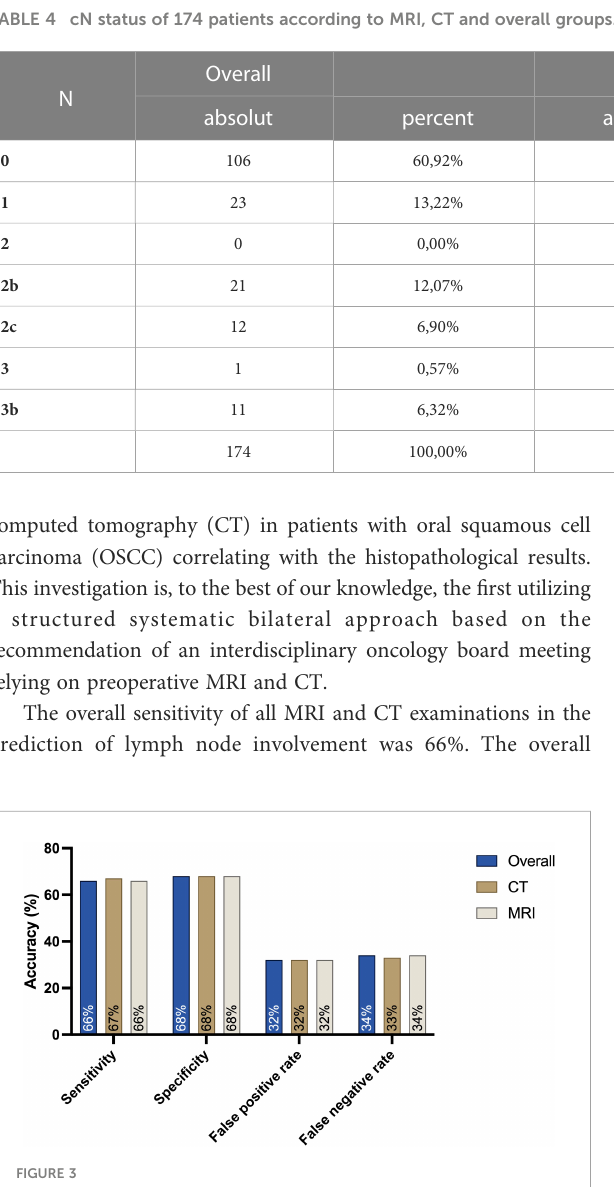
FIGURE 3 Sensitivity, speci fi city and false-positive and false-negative rates for the presence of any cervical lymph node metastasis when comparing the preoperative cN status based on MRI or CT fi ndings with the postoperative histopathological results: CT is the leading modality, with a high sensitivity of 67%. The speci fi city for both MRI and CT is